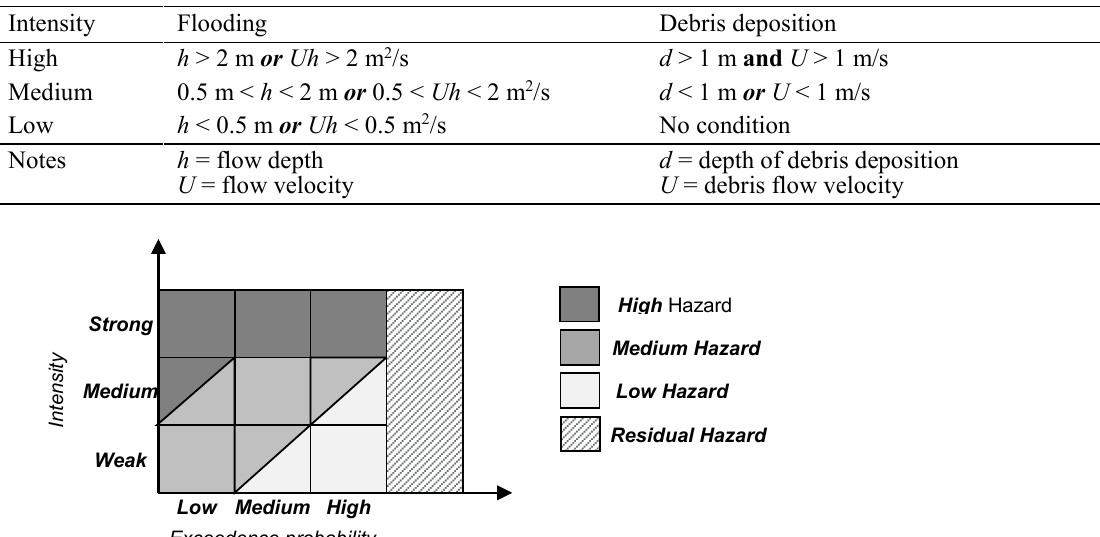
Table 1 Intensity classes.